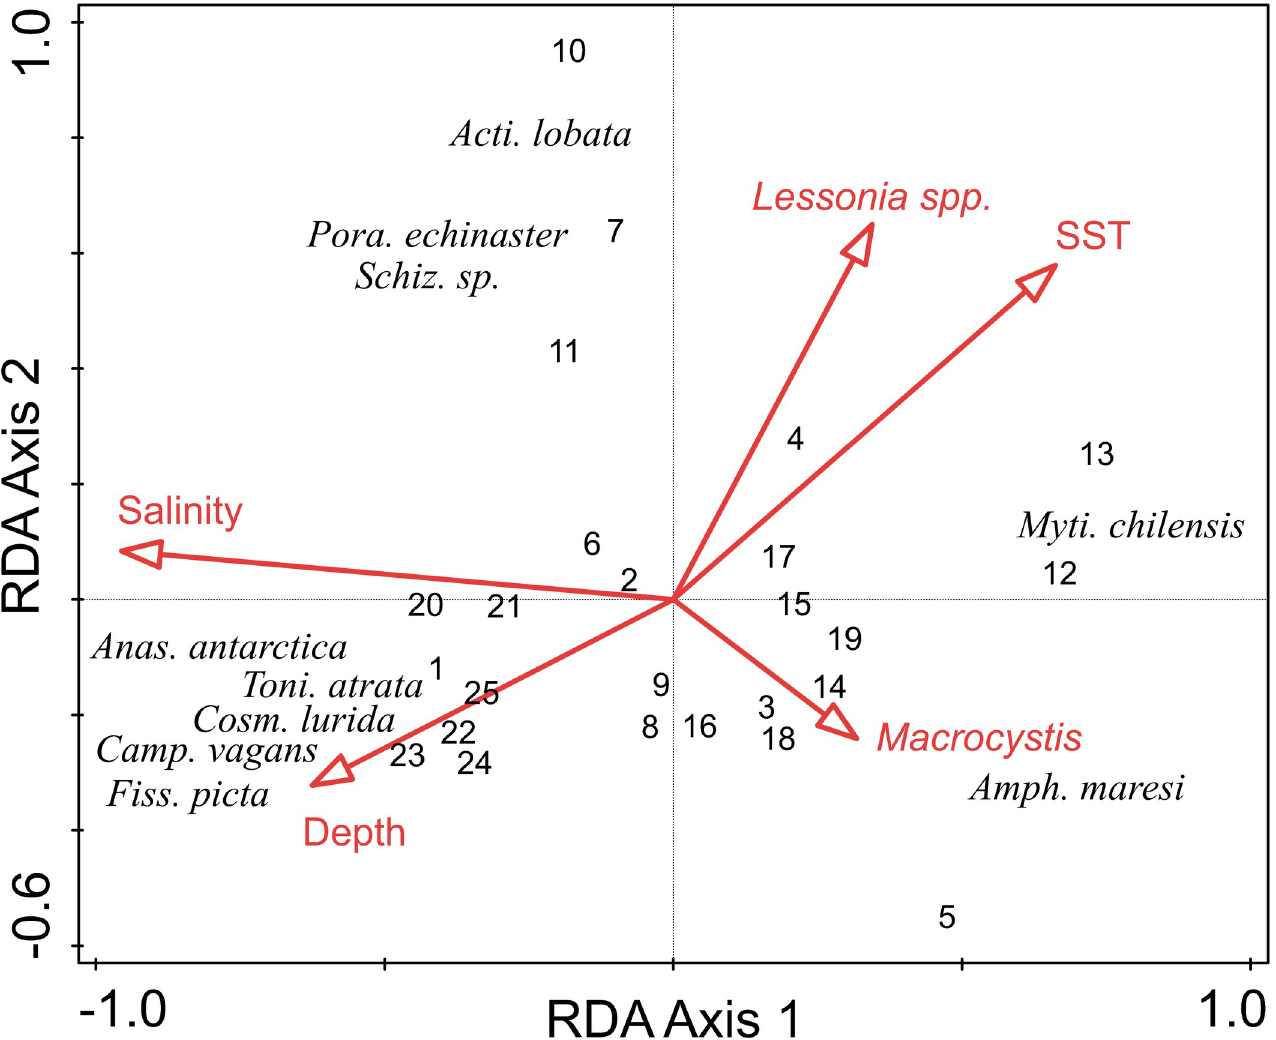
Fig 5. Triplot of results of redundancy analysis on benthic taxa abundance by location with environmental variables (depth, salinity, temperature). Data were centered and square root-transformed benthic taxa abundance by station. Environmental variables were standardized prior to analysis. Acti . lobate = Actinothoe lobata , Amph . maresi = Amphimedon maresi , Anas . antarctica = Anasterias antarctica , Camp . vagans = Campylonotus vagans , Cosm . lurida = Cosmasterias lurida , Fiss . picta = Fissurella picta + oriens , Myti . chilensis = Mytilus chilensis , Pora . echinaster = Poraniopsis echinaster , Schiz . sp. = Schizomavella spp., Toni . atrata = Tonicia atrata + calbucensis + chilensis + lebruni + smithii .